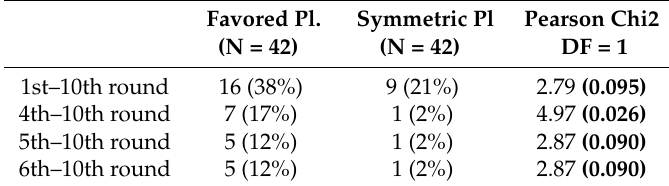
Table A3. Trade Restrictions by Type of Player and Treatment. Favored